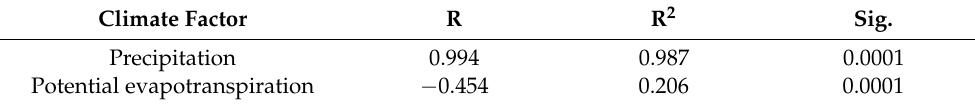
Table 8. The correlation analysis and statistics for water yield, precipitation and potential evapo- transpiration.